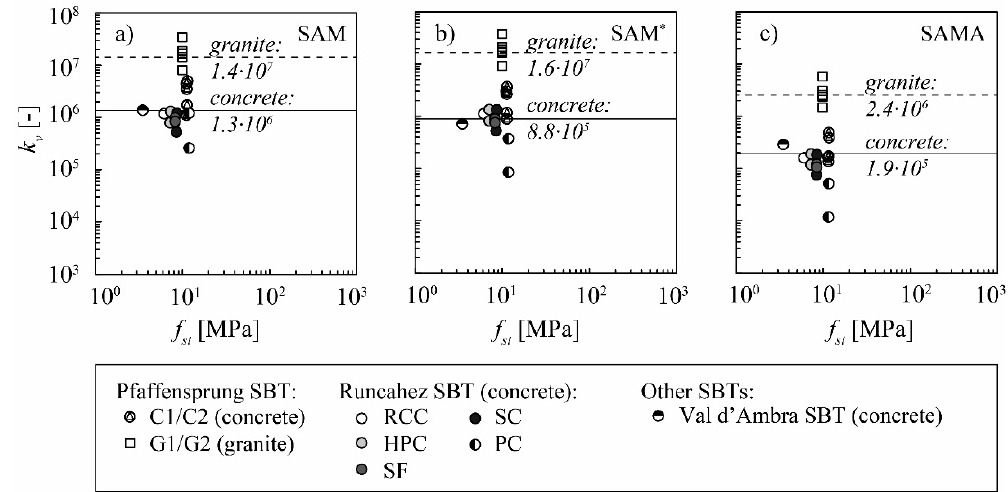
Figure 14. Abrasion coefficient k v as a function of splitting tensile strength of various SBT invert materials for ( a ) SAM, ( b ) SAM * and ( c ) SAMA.